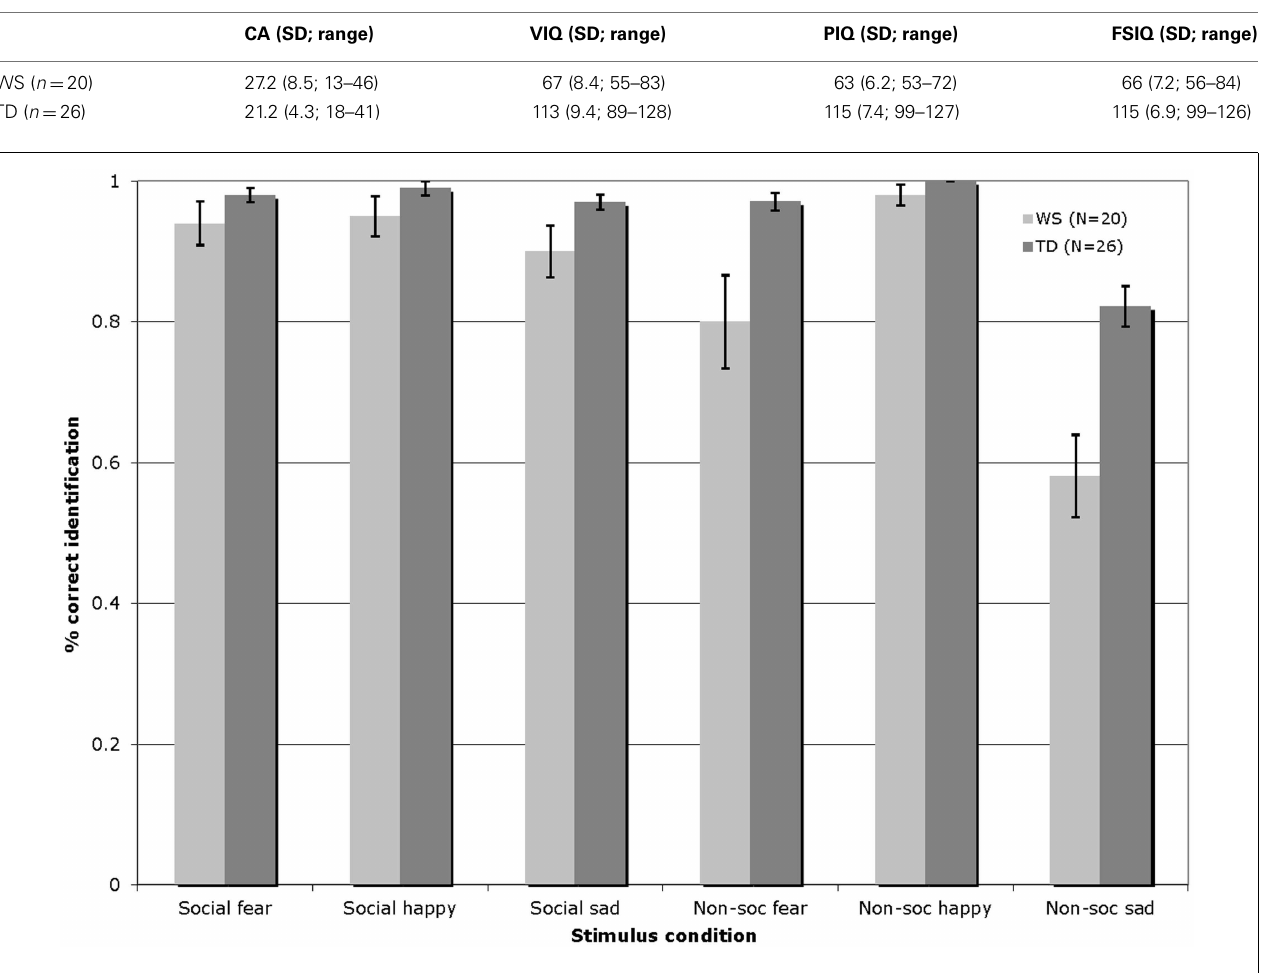
Table 2 | Mean characteristics of the participant groups (SD; range in parentheses) in Experiment 2.